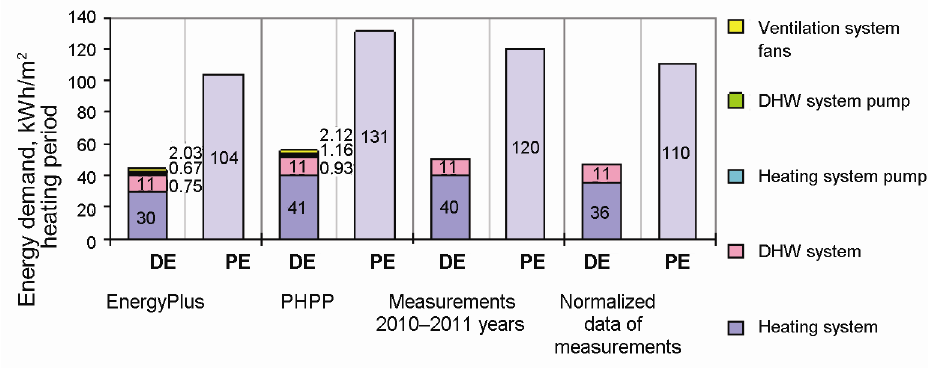
Fig. 6. Energy demand of the low energy house for heating period